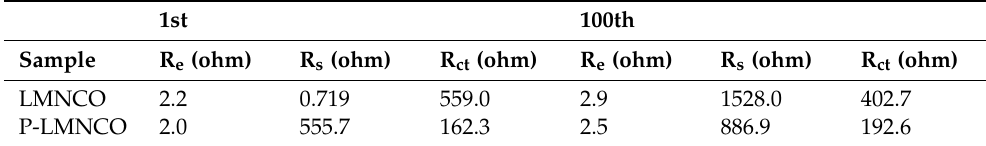
Table 1. The electrochemical impedance parameters of LMNCO and